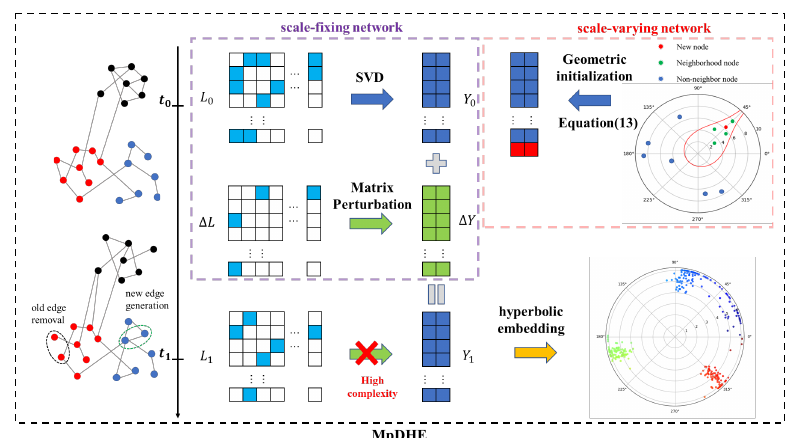
Figure 2. The overview of